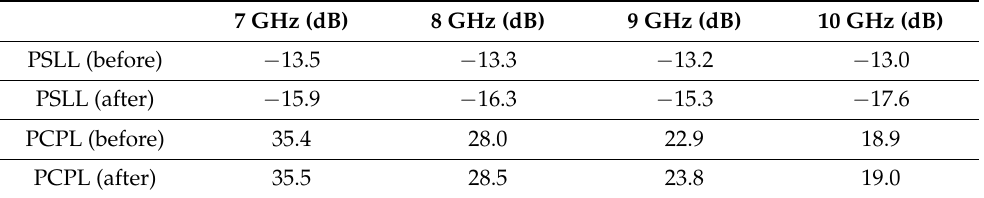
Figure 14. Co-polarization and cross-polarization patterns of the 8-element linear array at different frequencies before and after applying the optimal weight vectors in Table 9. ( a ) 7 GHz, ( b ) 8 GHz, ( c ) 9 GHz and ( d ) 10 GHz. Table 10. The PSLLs and PCPLs of the 8-element linear array before and after applying the proposed wide-nulling approach at 7GHz, 8GHz, 9GHz, and 10GHz.